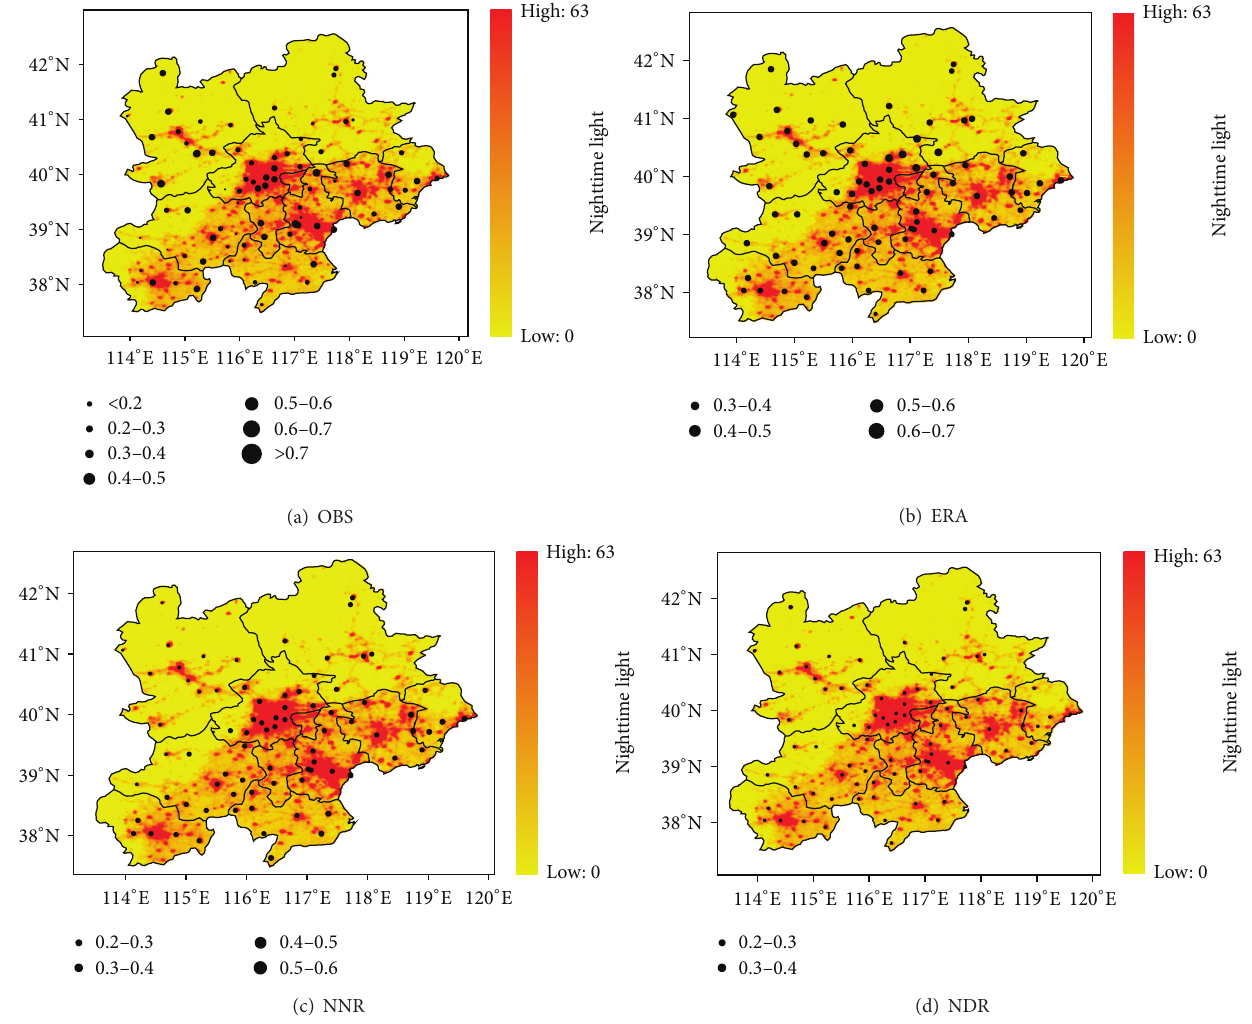
Figure 3: Annual mean SAT trends from (a) station observations (OBS), (b) ECMWF ERA-interim reanalysis data (ERA), (c) NCEP/NCAR reanalysis data (NNR), and (d) NCEP/DOE reanalysis data (NDR) during 1979–2009 (unit: ∘ Cdecade −1 ). Also shown is the DMSP/OLS nighttime light imagery from